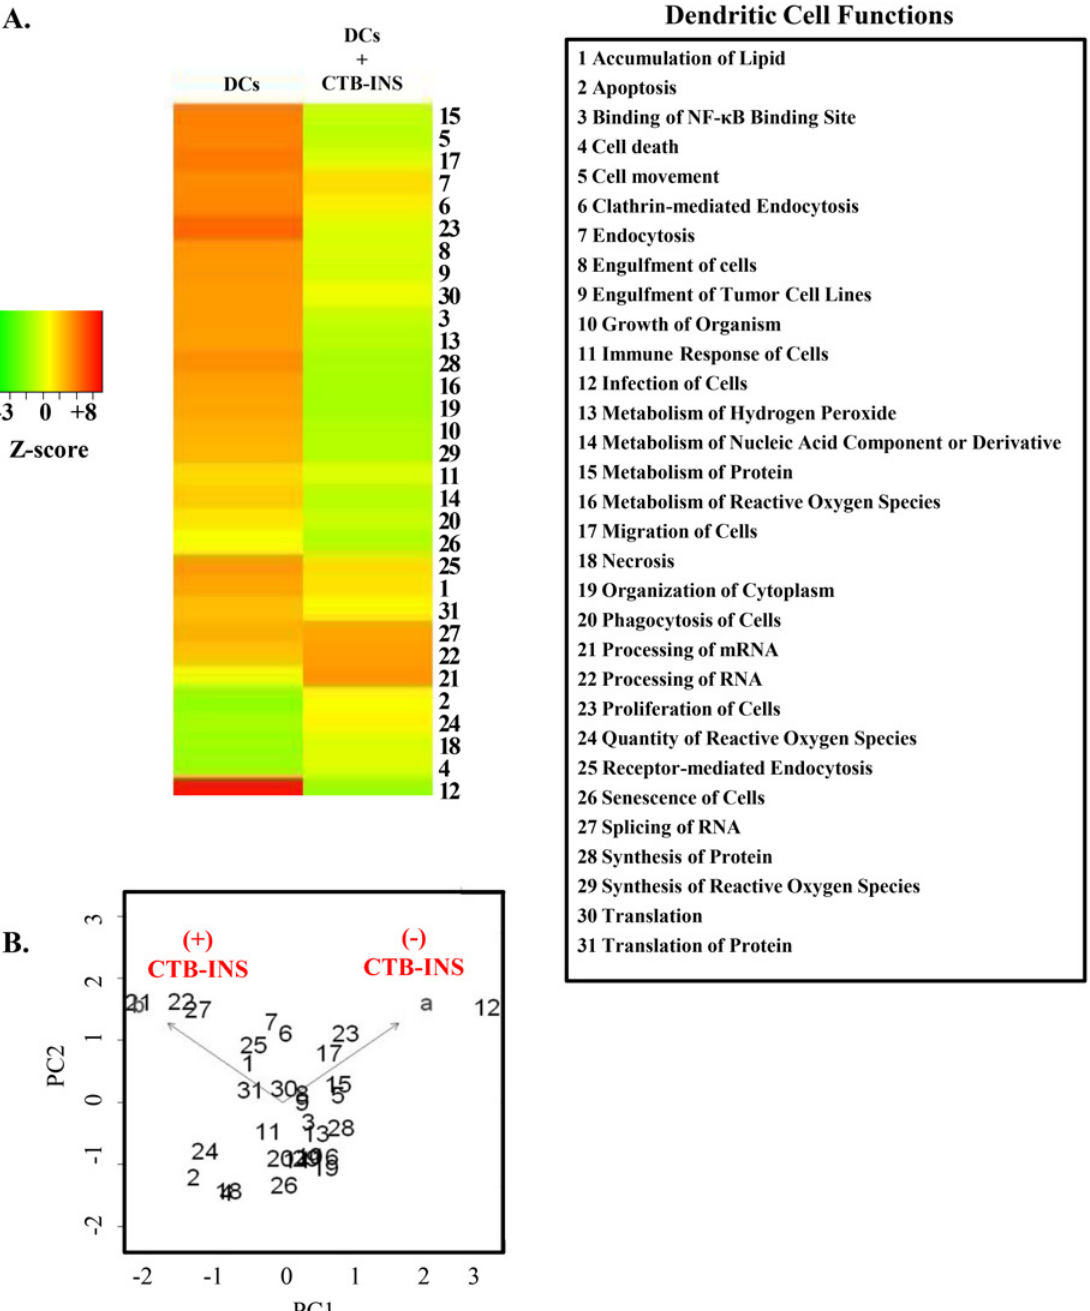
Fig 2. CTB-INS vaccine induced changes in DC cellular functions. (A) Heat map representing cellular functions (z-scores * ) identified in vaccinated dendritic cells. Red bands indicate up-regulated cellular functions, yellow bands indicate no change in function and green bands indicate down-regulated cellular functions. (B) Principal component (PC) analysis of dendritic cell functions, z-scores. The Bi-plot correlates dendritic cell functions (+/-) vaccine treatments as indicated by the proximity of individual DC functions (numbers) to either vector arrowhead [a = CTB-INS (-), b = CTB-INS (+)]. Numbers further from the mean in the direction of the vector exhibit an increased correlation of the DC function with a or b. Example: Function #12 is highly correlated with unvaccinated DCs, [CTB-INS (-)] and Function #2 is poorly correlated with vaccinated DCs, [CTB-INS (+)]. Zero (0) is the weighted mean of the multivariate dataset. The values on the (x; y) axis represent (+/-) deviation from the mean of the dataset (0). ( * z-score = statistical measurement of a score ’ s relationship to the mean in a group of scores. A z-score of 0 means the score is the same as the mean. A z-score can also be positive or negative, indicating whether it is above or below the mean and by how many standard